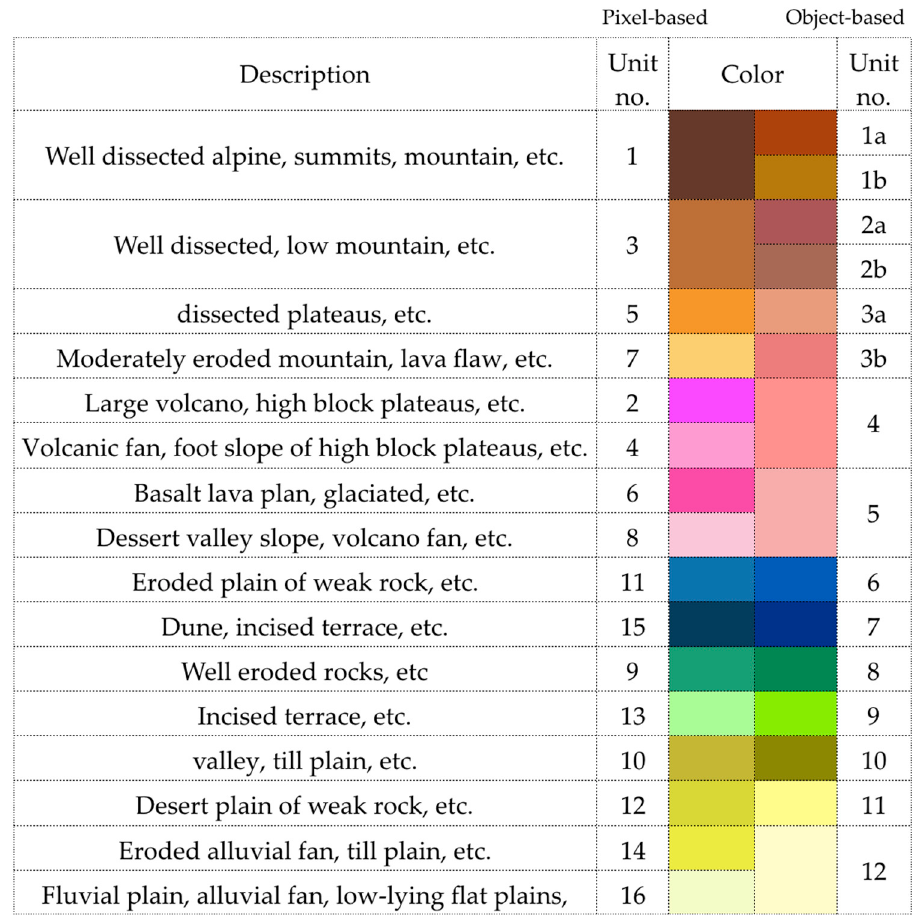
Figure 4. Descriptions of classified geomorphology units from pixel-based classification (PBC) and object-based classification (OBC) [9,50].